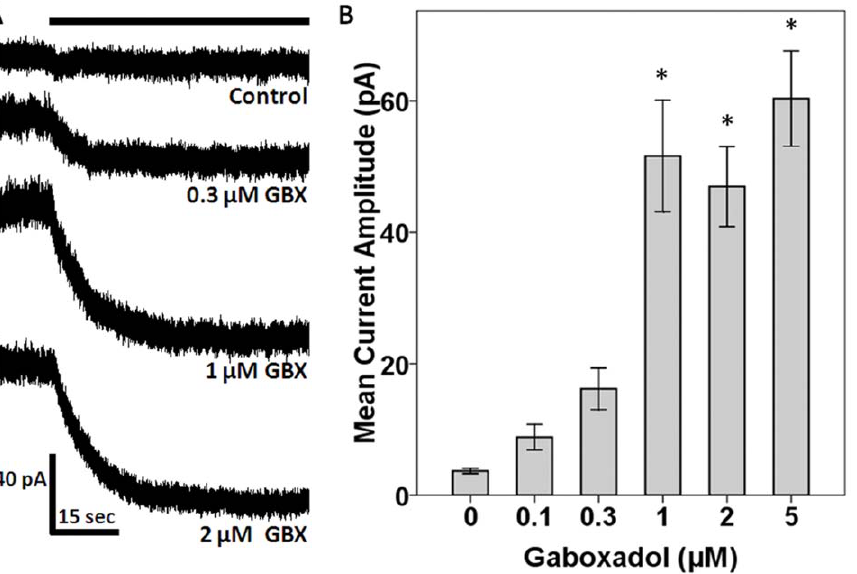
Figure 2. GABA A R Mediated Tonic Inhibition in MGB Neurons: A ) Representative traces of gaboxadol-induced tonic Cl 2 currents (outward) revealed by gabazine block, resulting in an inward shift in baseline current for MGB neurons held at 2 10 mV. The solid black line above the first trace represents the continuous focal application of (50 m M) gabazine for all traces. B ) Bar graph of tonic current amplitude changes revealed by focal application of gabazine in the presence of increasing concentrations of GABA A R agonist, gaboxadol (GBX), applied to the ACSF. Current amplitudes are represented on the y-axis with the concentration of gaboxadol on the x-axis. (* p , 0.005 when compared to Control using Dunnett’s post-hoc analysis, data underwent first-order Winsorization; n=control: 8; 0.1 m M: 4; 0.3 m M: 6; 1 m M: 6; 2 m M: 6; 5 m M: 6).